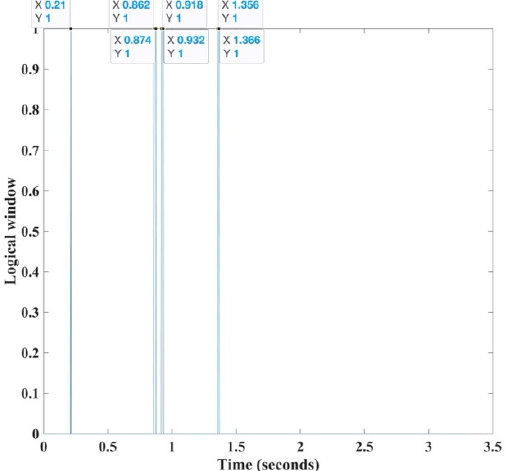
Figure 3. The outlier detection window (applied to trace 45 of Yilmaz shot record 23) is a logical array of ones and zeros. The first outlier (at time 0.21 s) is noise as it is a window of one sample only (thus ignored). The second window (at time 0.862–0.874 s) is an array of ones and it is our first arrival window. The third (at time 0.918–0.932 s) and fourth (at time 1.356–1.366 s) windows nearly match the size of the first arrival window but come later and, thus, are defined as later arrivals.